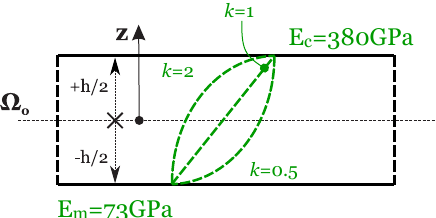
Figure 5. Functionally Graded Material (FGM) configuration and elastic properties for Cases 1 and 2.